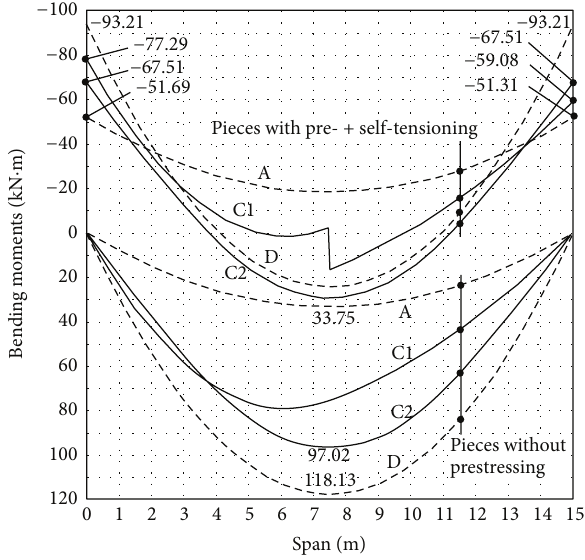
Figure 14: Bending moments hypotheses (A), (C1), (C2), and (D), F4 structural floor type, sections (S1) and